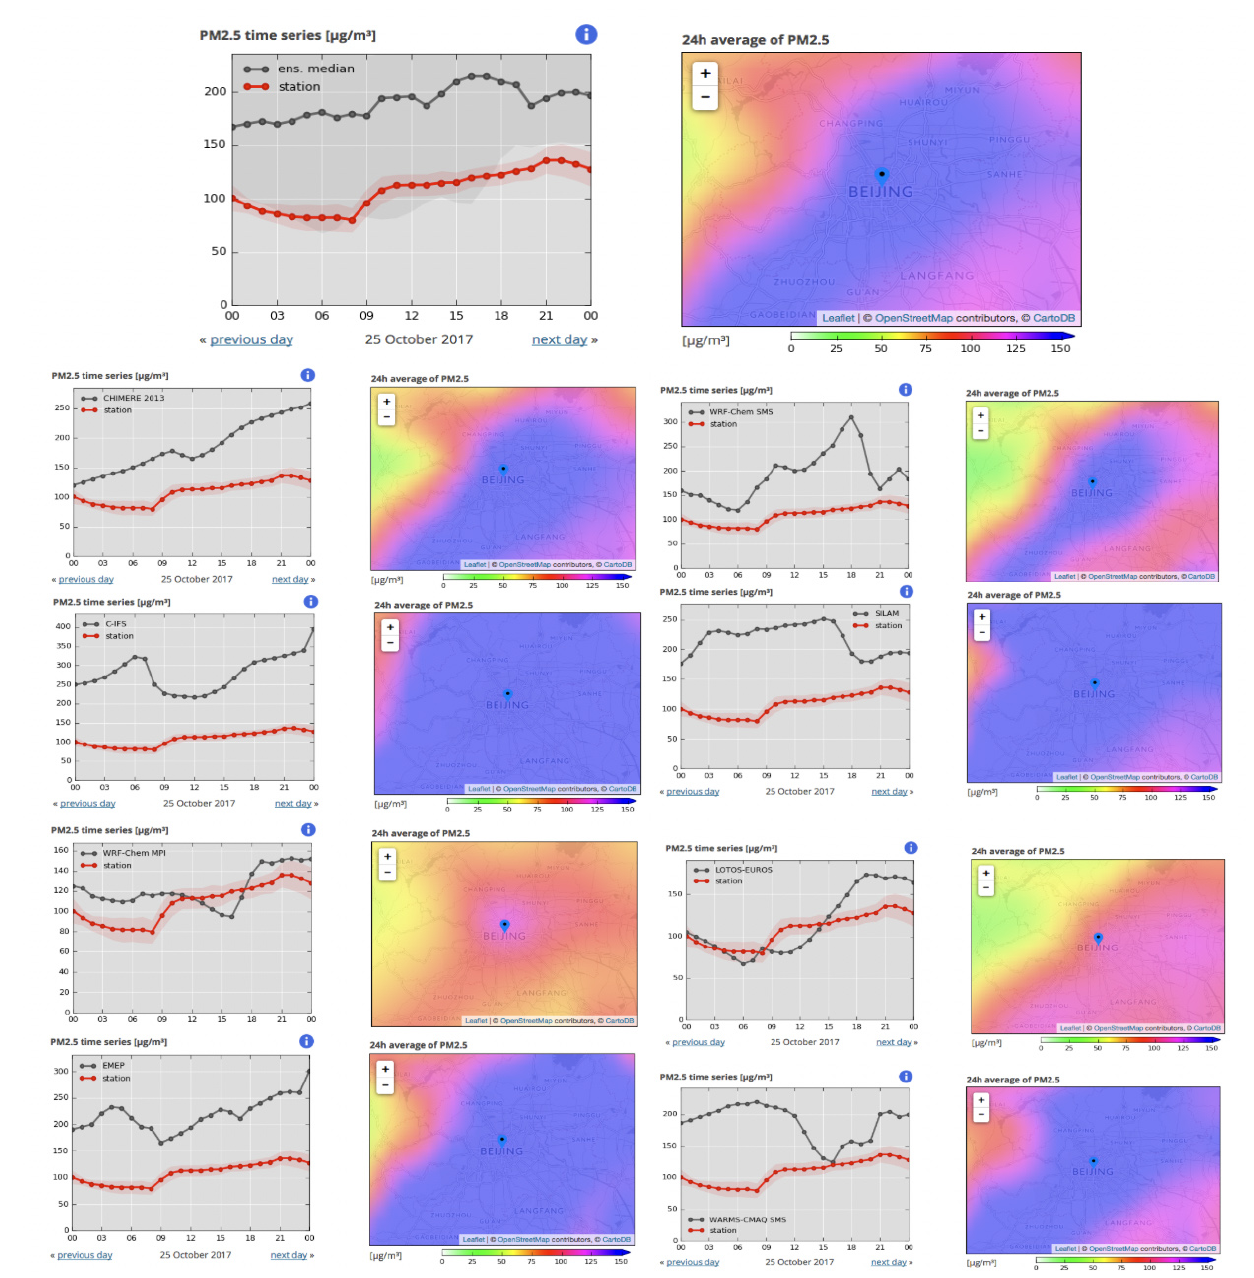
Figure 5. Diversity of PM 2 . 5 forecasts in Beijing on 25 October 2017 by several models included in the ensemble of the MarcoPolo–Panda prediction system. The ensemble median is shown by the top panels, and the individual forecasts provided by CHIMERE, IFS, WRF-Chem- MPIM, EMEP, WRF-Chem-SMS, SILAM, LOTOS-EUROS, and WARMS-CMAQ-SMS are shown by the other panels. Measurements are in red and model data in